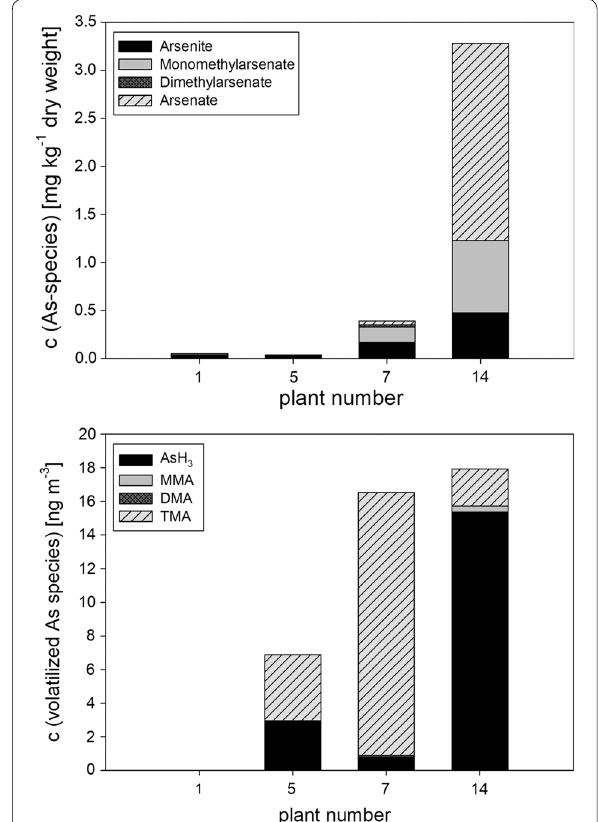
Fig. 3 Quantification of the As species in the liquid phase (top) and the produced gas (bottom) of four selected technical plants. The x‑axis assigns the plants (numbering as indicated in Table 1). In the liquid phase, only the dissolved (ionic) species were analyzed. Volatile species were only analyzed in the gas